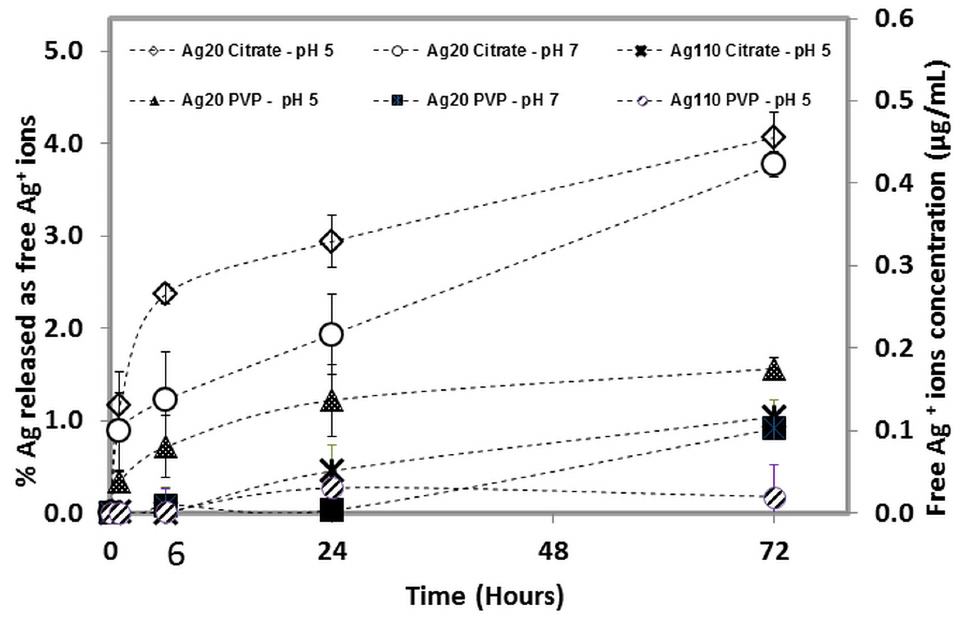
Fig 2. Dissolution kinetics of AgNP. Ag + ion release from citrate and PVP-capped Ag20 and Ag110 NP incubated in perchlorate acid/ perchlorate buffer solutions (pH 5, and 7).